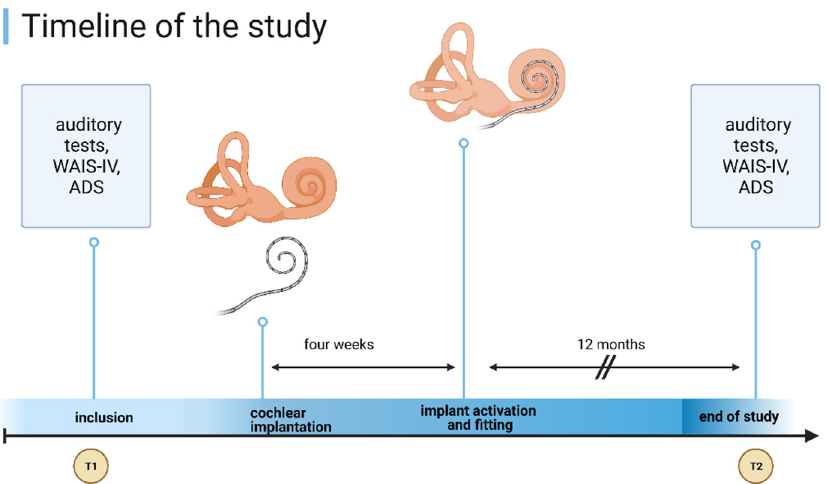
Figure 1. Study design and timeline. Examination point: T1 = inclusion into the study before CI and first evaluation; T2 = 12 months after first CI fitting and second evaluation. Created with BioRender.com (accessed on 9 June 2021).